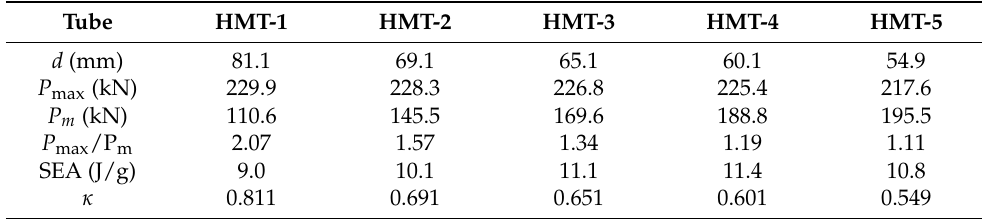
Table 8. FEM-simulated crushing data of HMTs based on PF method.